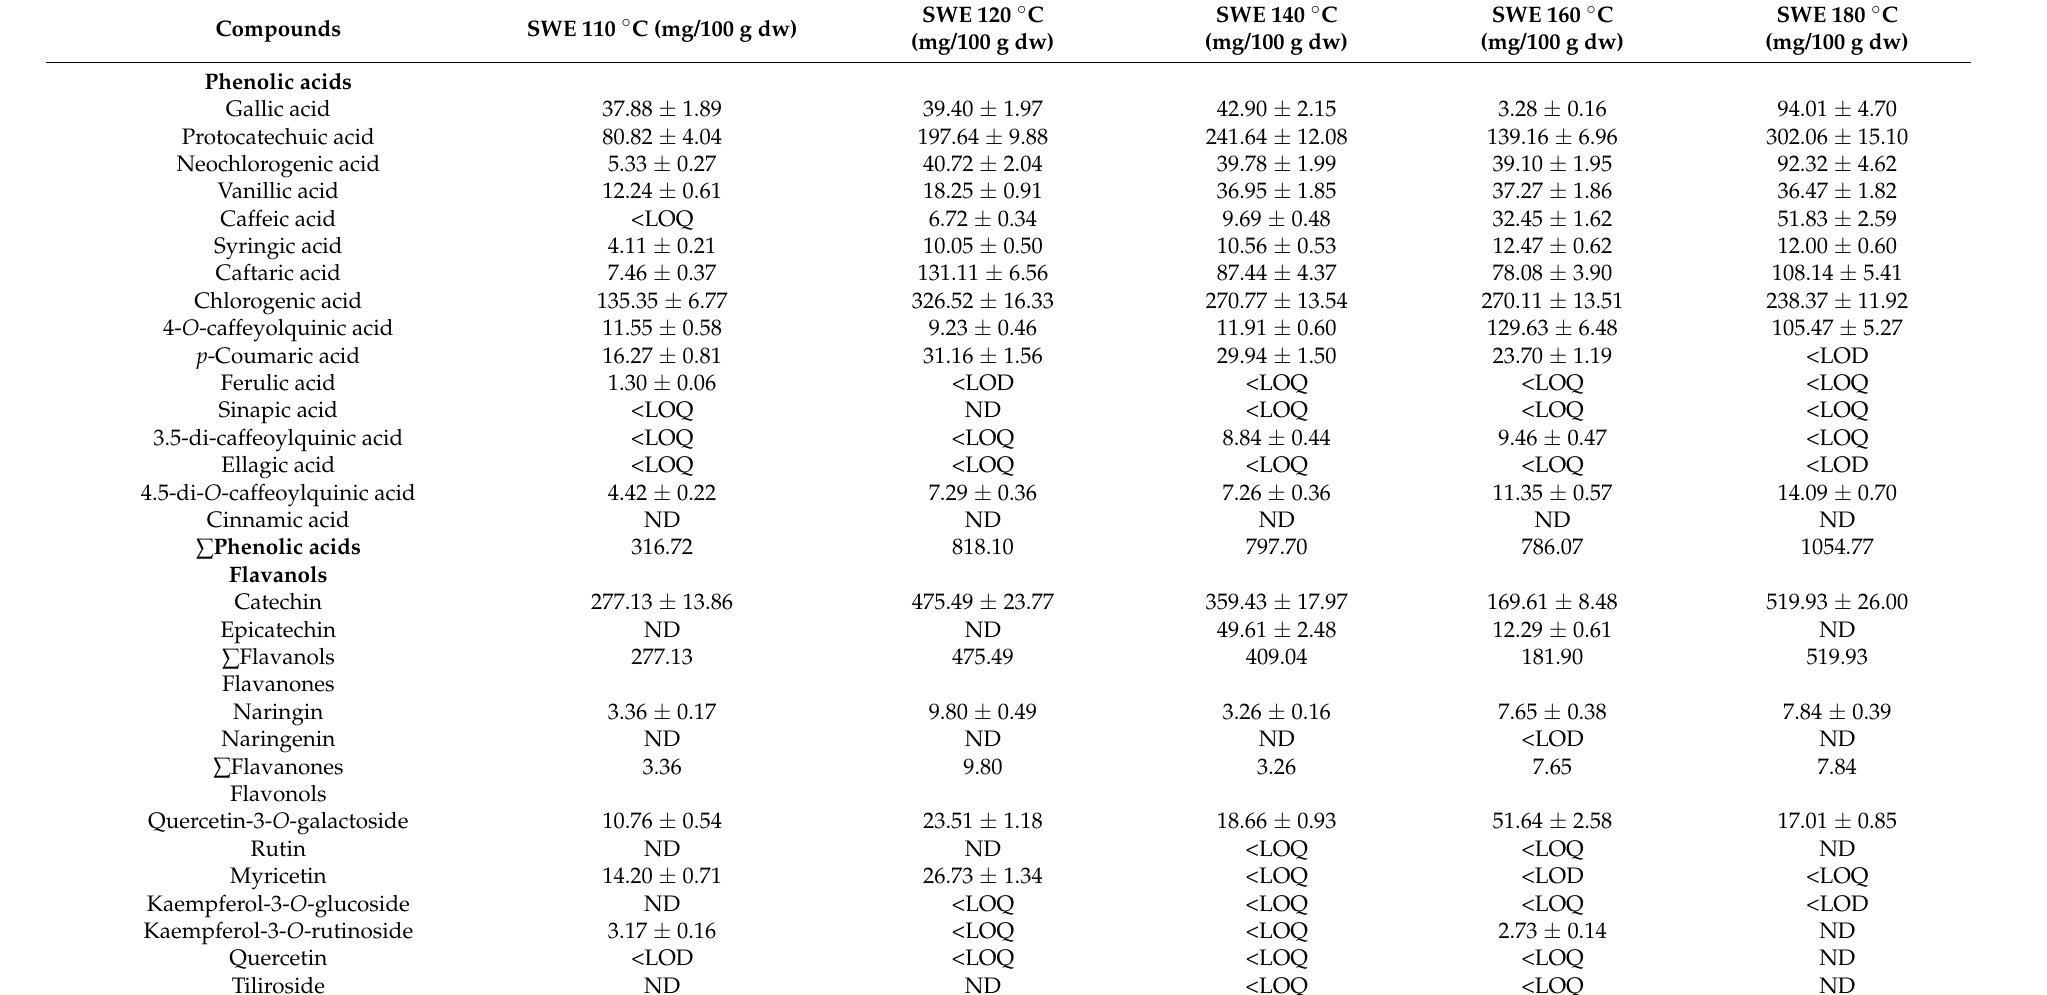
Table 2. Identification and quantification of the bioactive compounds present in S. ramosissima extracted at 110 ◦ C, 120 ◦ C, 140 ◦ C, 160 ◦ C and 180 ◦ C. Results were expressed as mean ± standard deviations (mg of compound/100 g